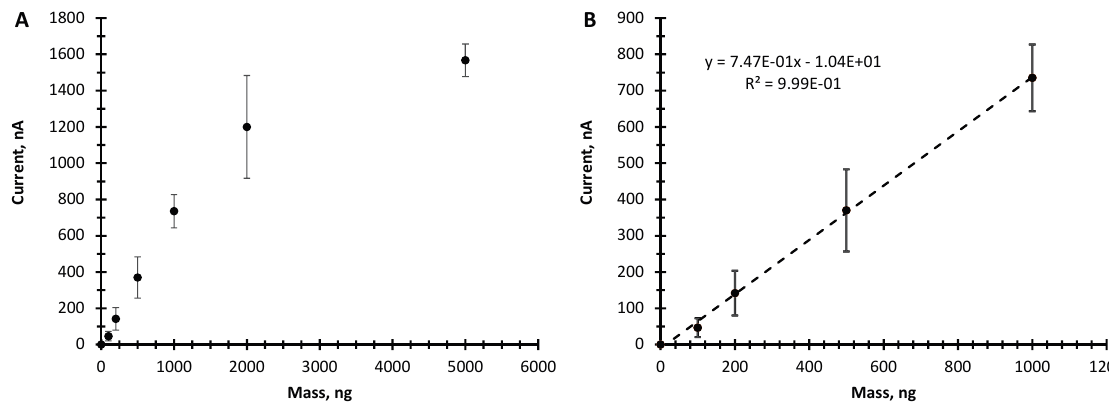
y = 7.47E-01x - 1.04E+01 R² =